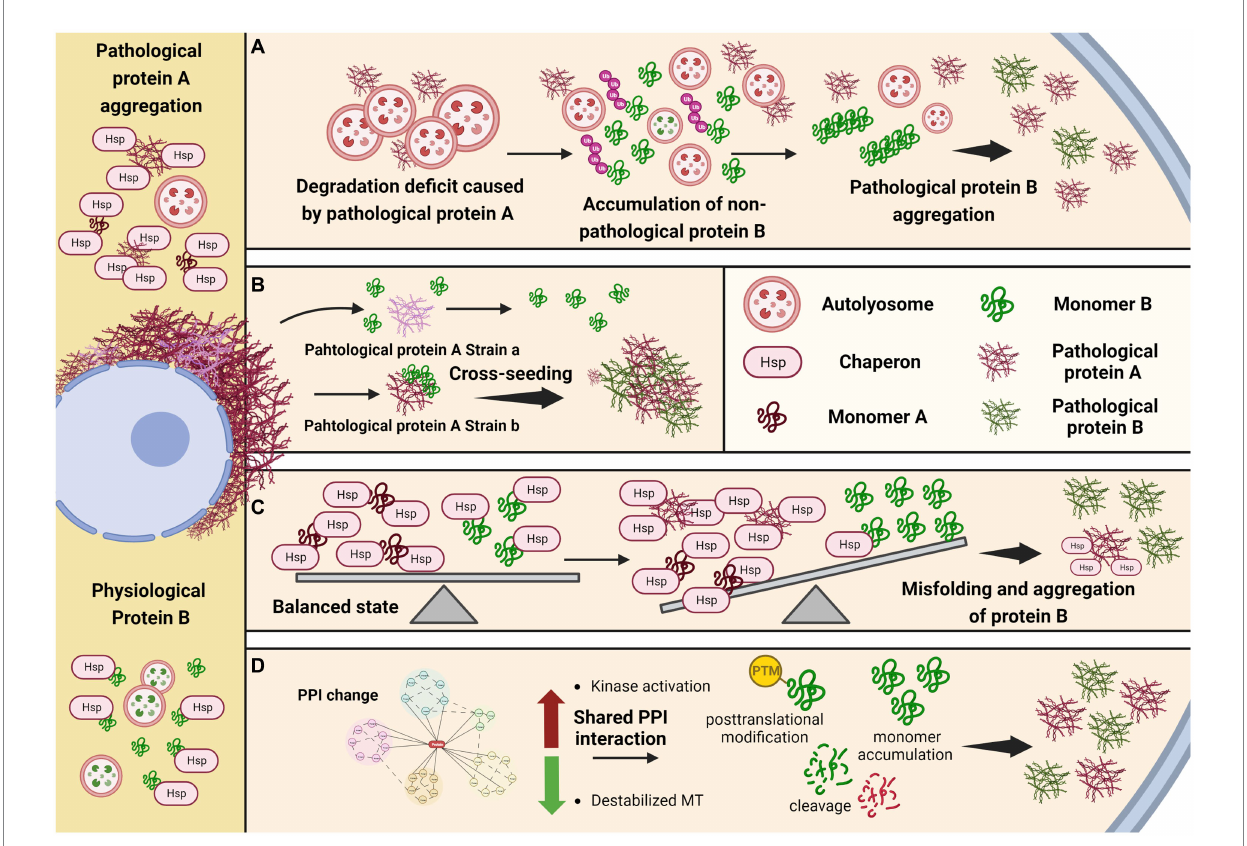
FIGURE 1 Potential mechanisms underlying comorbid pathogenesis in neurodegenerative diseases. (A) Protein aggregation caused by defective global protein degradation. (B) Specific conformational strain cross-seeding the other amyloid protein. (C) Loss of protein quality control due to limited chaperone molecule. (D) Shared regulation pathway and posttranslational modification facilitate the aggregation of the other